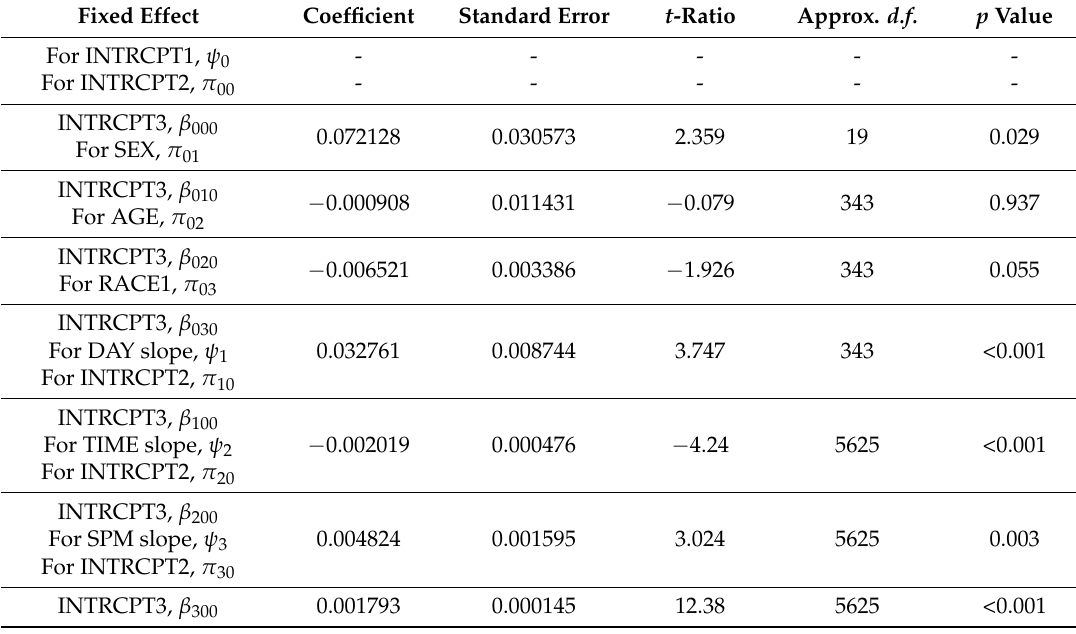
Table 3. Hierarchical linear modeling (HLM) for moderate to vigorous physical activity with three-level